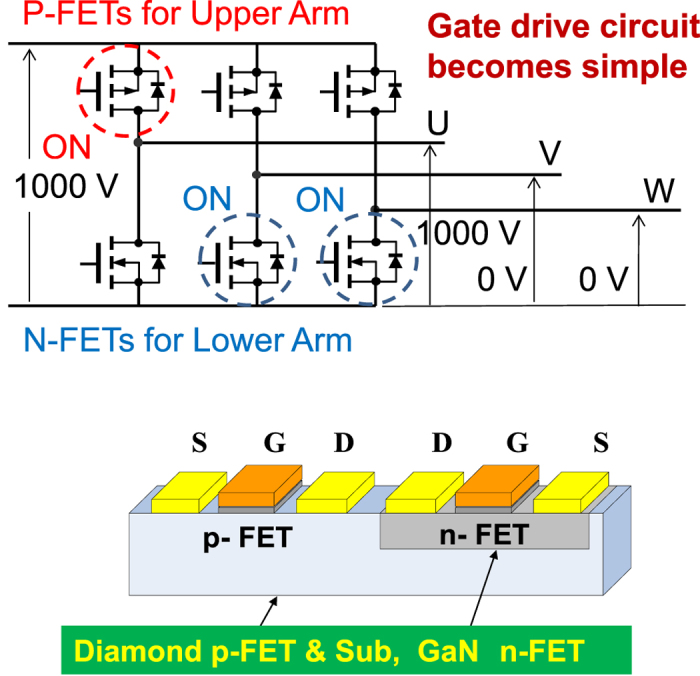
System of complementary wide bandgap semiconductor devices such as that used for power inverters, where the source potentials of the n-channel FETs in the lower arm and the p-channel FETs in the upper arm are fixed at ground level and at a high level, respectively.This is an almost ideal circuit and is much simpler than that used in current inverter circuits, in which n-channel FETs are used in both the upper and lower arms, and the source potential in the upper arm is not fixed and thus must be changed by on-off switching. An extra gate drive circuit is needed in the current inverter circuit to apply the appropriate gate-source voltage, but is not required in the complementary system shown.